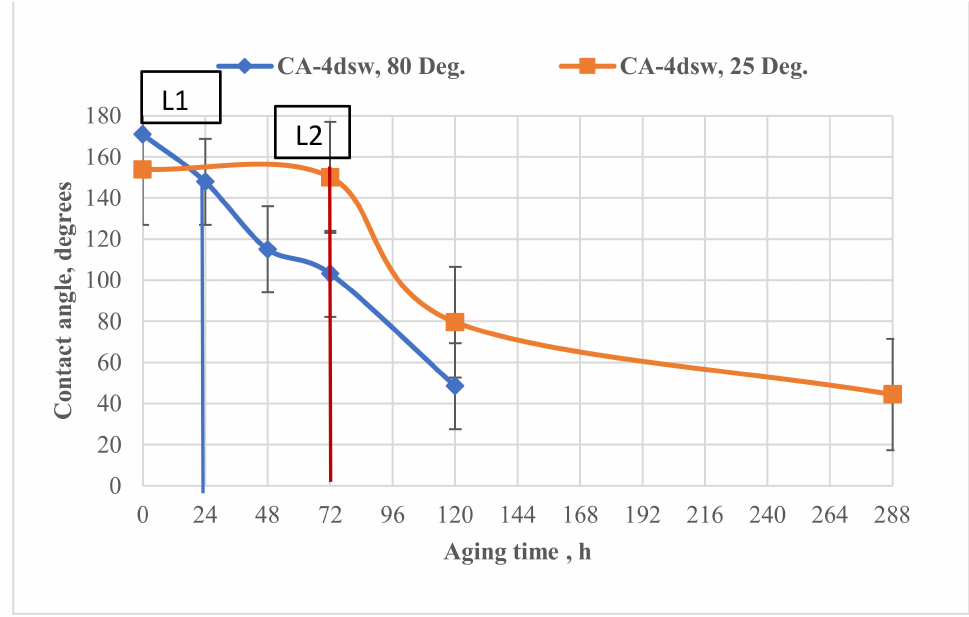
Figure 10. Effect of dilution on the contact angle, at ambient temperature and an elevated temperature of 80 ◦ C.